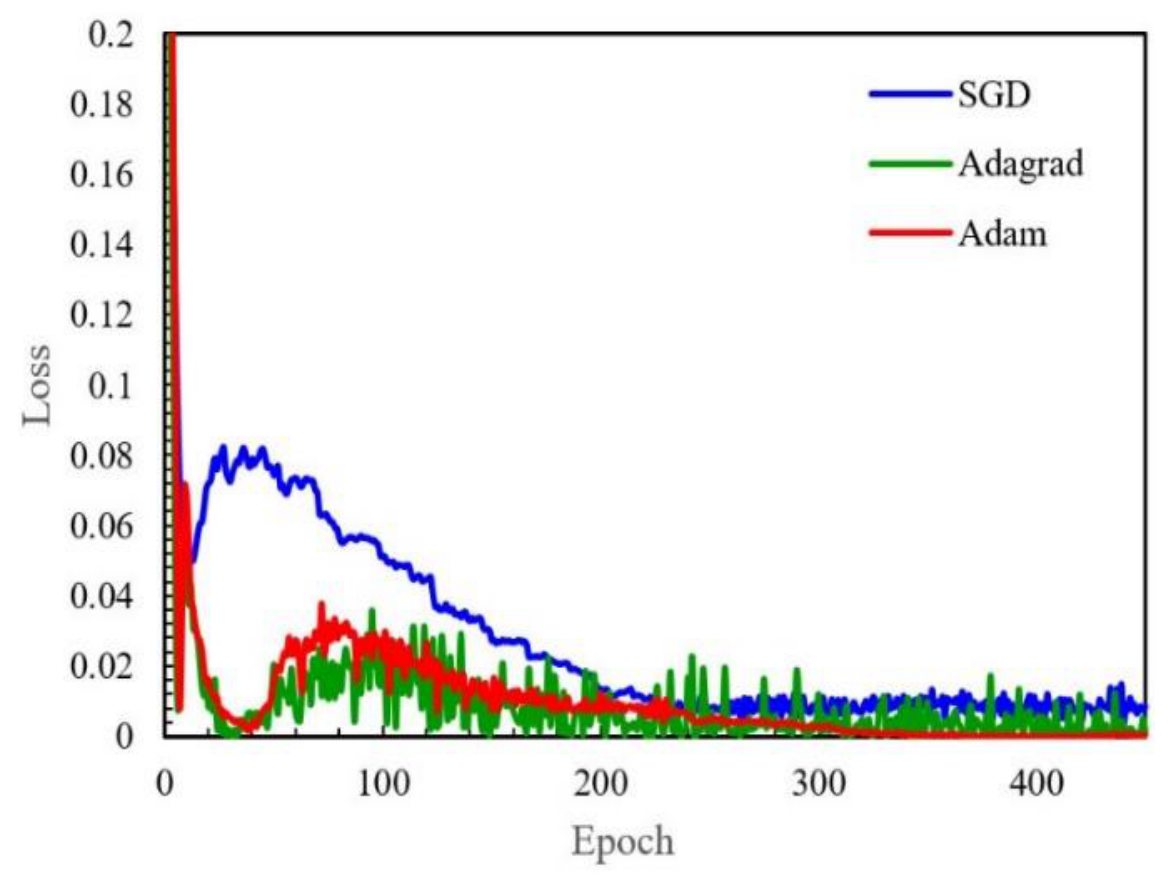
Figure 3. Loss curve of optimizer algorithms.